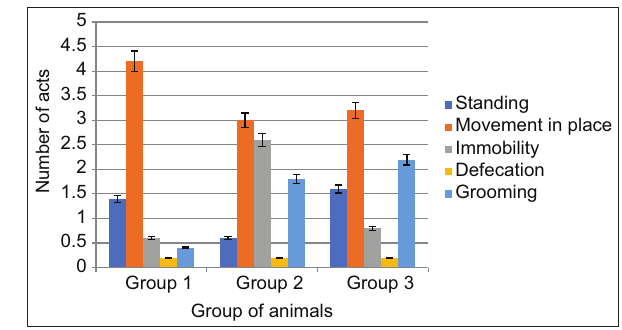
Figure-2: Changes in the time of acts of locomotion, sniffing, and stand with the support of animals when exposed from the Samsung Galaxy J1 Mini and Xiaomi Redmi S2 phones.